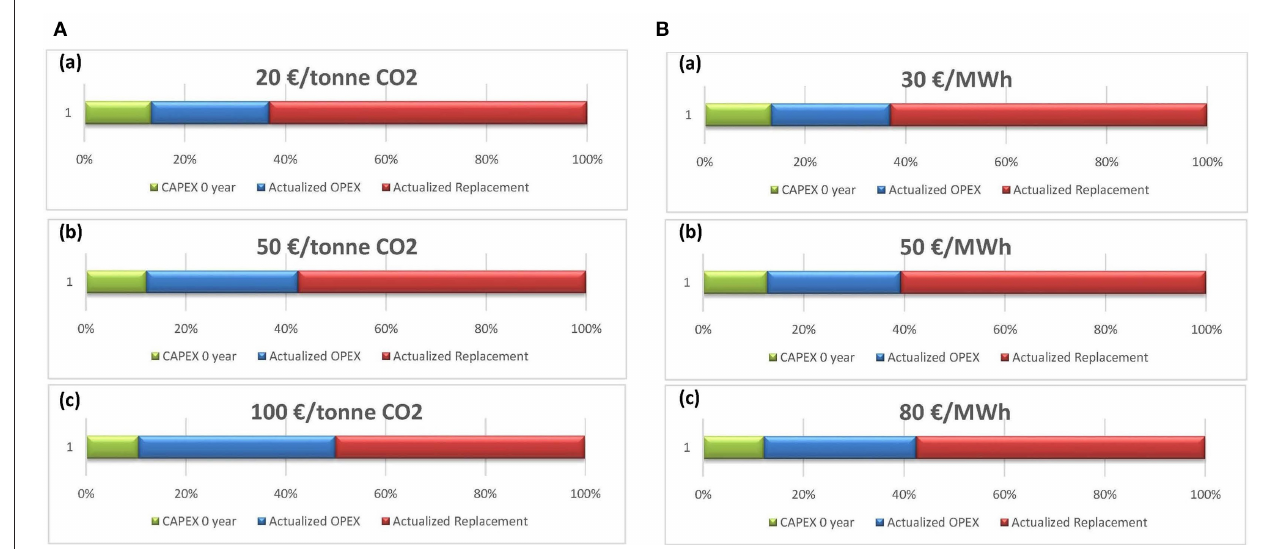
FIGURE 12 | Methane cost breakdown based on CAPEX, OPEX, and replacement of the equipment against variation on CO 2 (A) and electricity cost (B) . (A) CO 2 cost from (a) 20 e /ton, (b) 50 e /ton, into (c) 100 e /ton. (B) Electricity cost from (a) 30 e /MWh, (b) 50 e /MWh, into (c) 80 e /MWh. ( Figure 10B ). This minor variation contributes to a